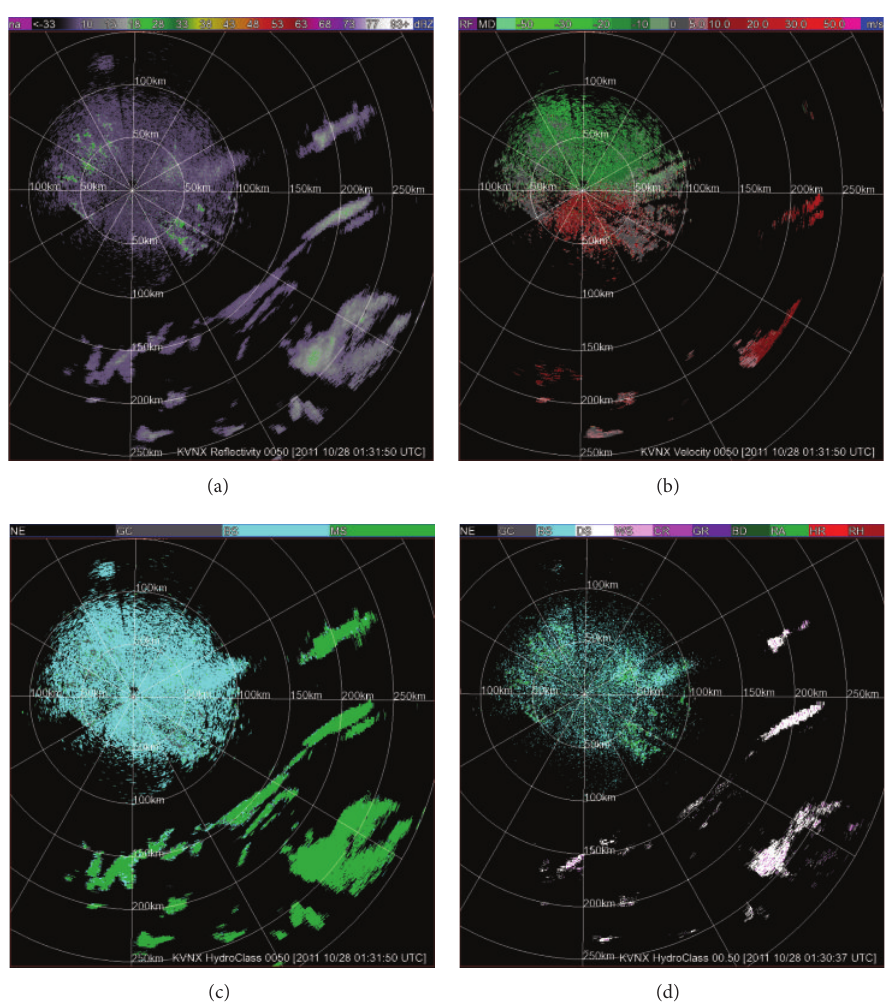
Figure 5: Images of (a) 𝑍 , (b) V 𝑟 , (c) classification results produced by the simplified HCA, and (d) classification results produced by the original HCA from the KVNX 0.5 ∘ scan at 013150 UTC on 28 October 2011. The 10 classes in the original HCA are: (1) ground clutter including that due to anomalous propagation (GC/AP); (2) biological scatterers (BS); (3) dry aggregated snow (DS); (4) wet snow (WS); (5) crystals of various orientations (CR); (6) graupel (GR); (7) “big drops” (BD); (8) light and moderate rain (RA); (9) heavy rain (HR); and (10) a mixture of rain and hail (RH). The spatial resolutions of the original data are the same as in Figure